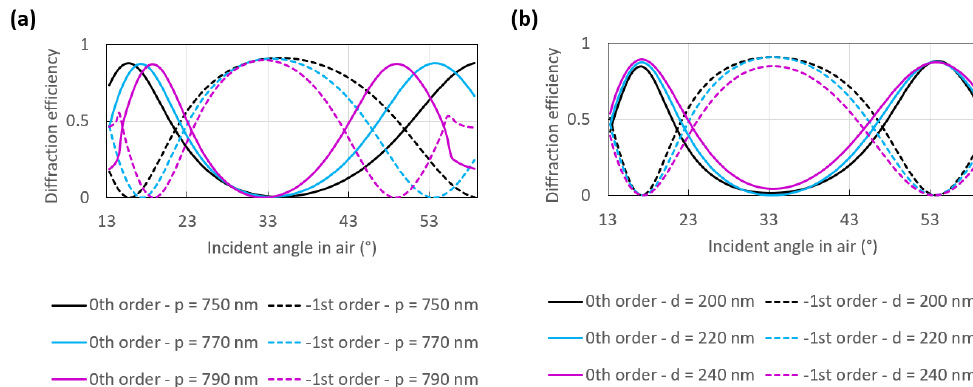
Figure A2. ( a ) Computed angular response for an ideal sinusoidal grating of depth 220 nm, covered by water ( n = 1.33), under plane wave incidence at λ 0 = 850 nm depending on the period. ( b ) Computed angular response for an ideal sinusoidal grating of period 770 nm, covered by water ( n = 1.33), under plane wave incidence at λ 0 = 850 nm depending on the depth. The switch patterns were computed using MC